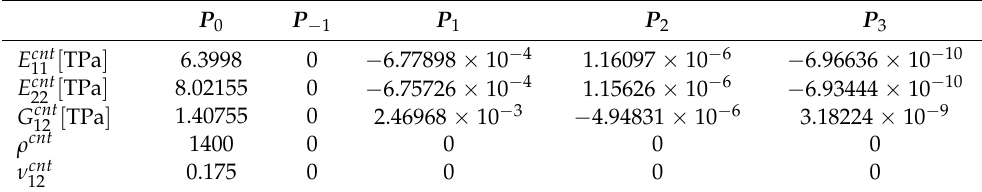
Figure 4. Variation of the non-dimensional frequency parameter (cid:3435)𝜔(cid:3557) = 𝜔ℎ(cid:3493)𝜌 (cid:3030) 𝐸 (cid:3030) ⁄ (cid:3439) with the material gradation index, P for simply supported Al/Al 2 O 3 functionally graded square plates and doubly curved shells ( a = b = 10 h , m = n = 1).